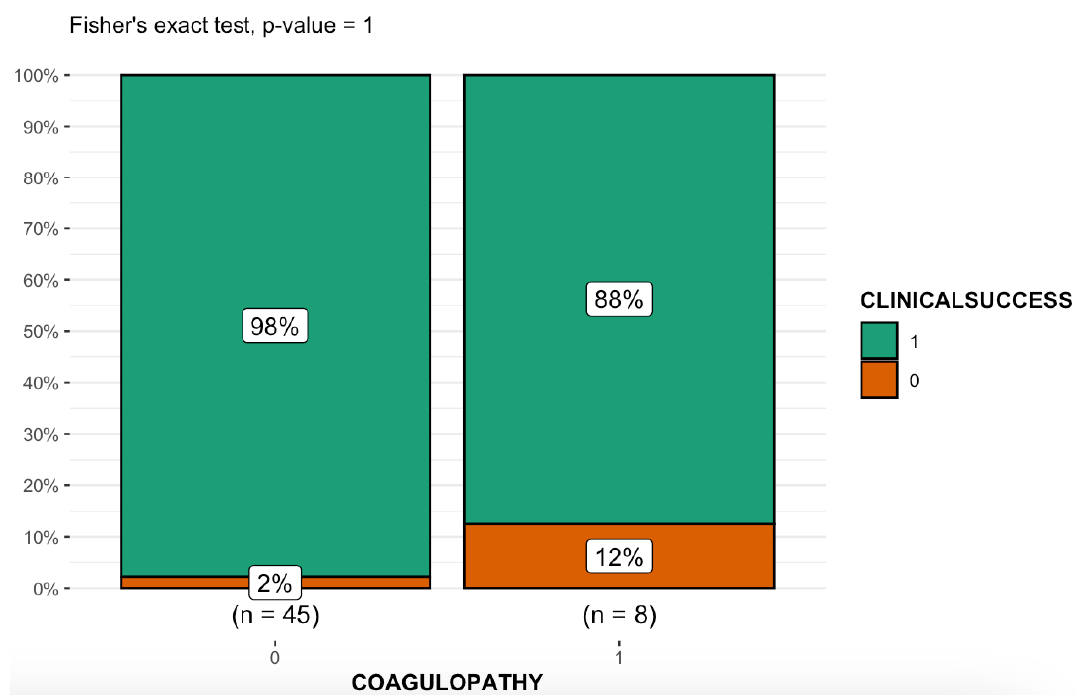
Figure 4. Boxplot representing the relationship between the two categorical variables, “Coagulopathy” and “Clinical Success”, analyzed using Fisher’s exact test.